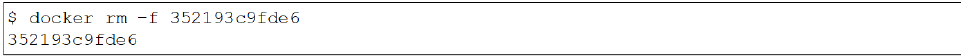
Figure 29. Delete the docker container in the ubuntu_target container.